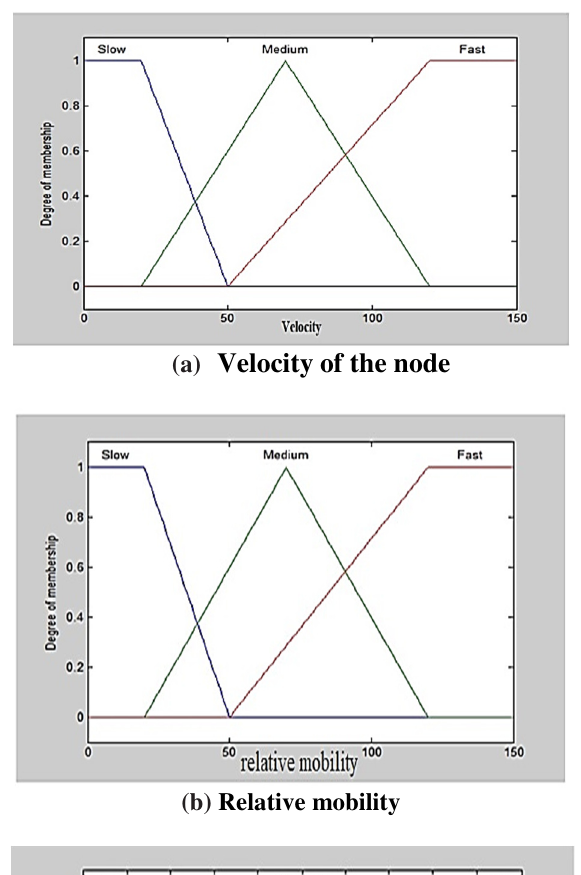
Fig. 5. Mobility Factor Calculation